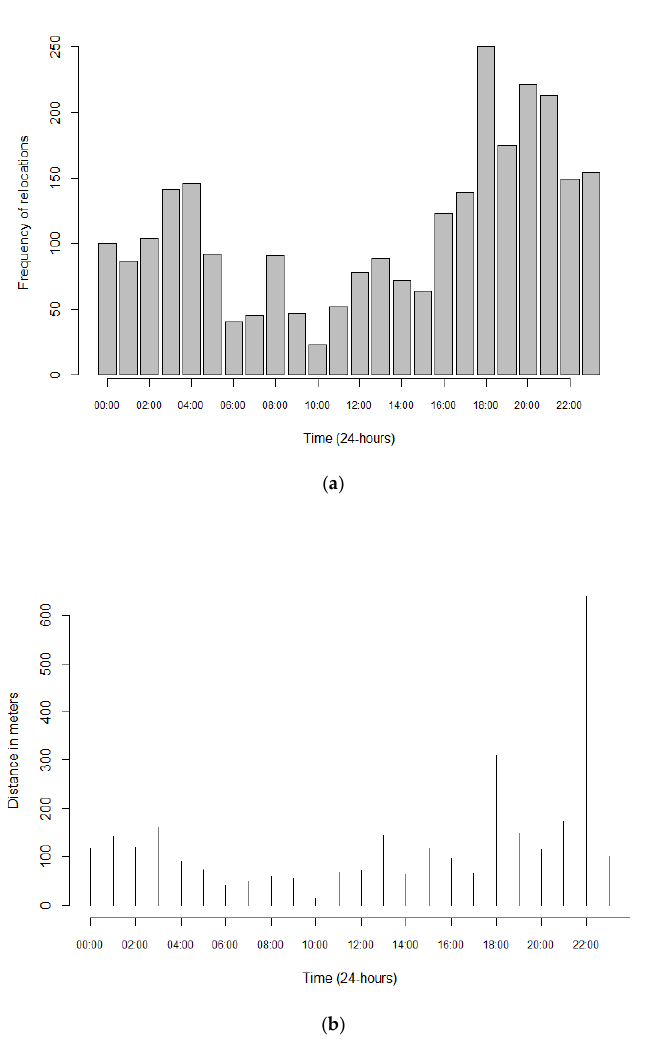
Figure 1. Frequency of relocations (count; ( a )) and the corresponding distance (m; ( b )) traveled by the calves over a 24 h period.